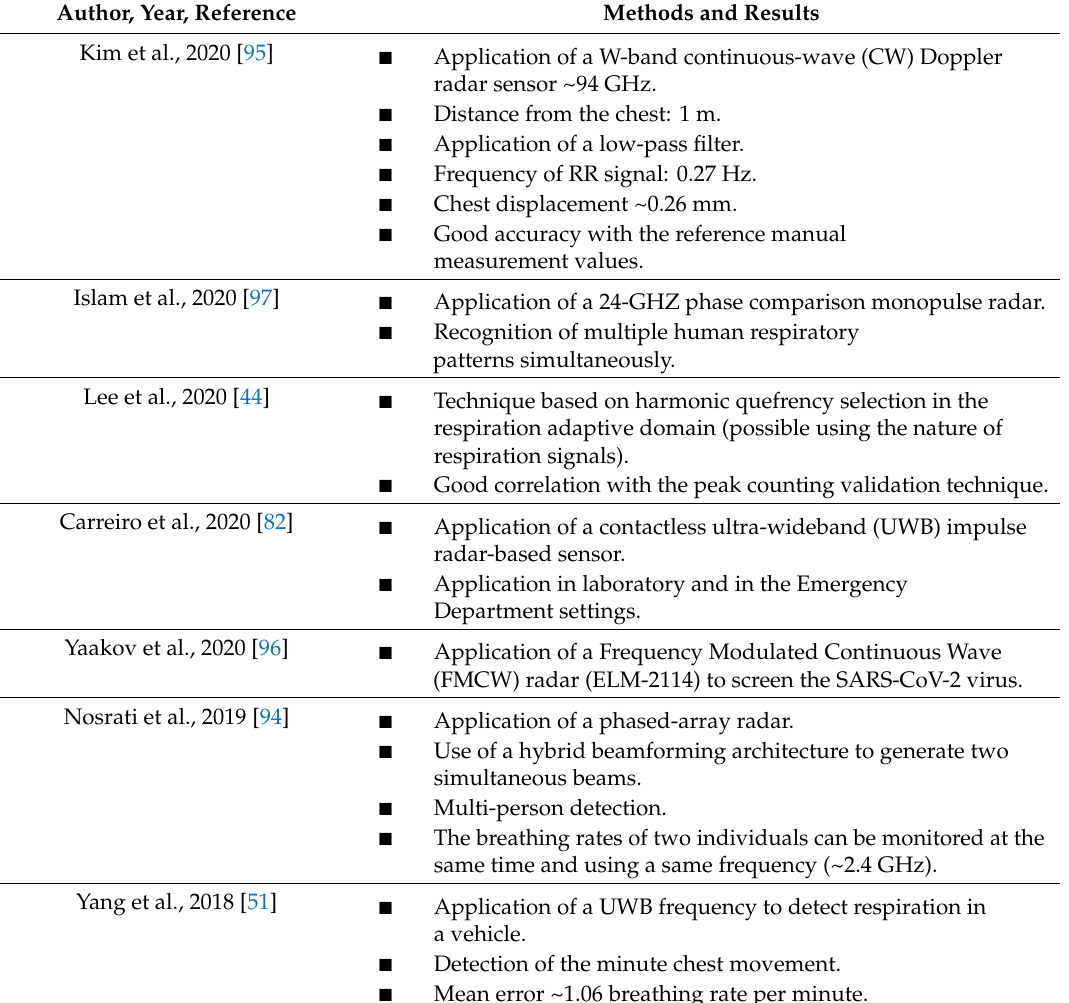
Table 2. Examples of works using radar sensors for respiration assessment over the last few